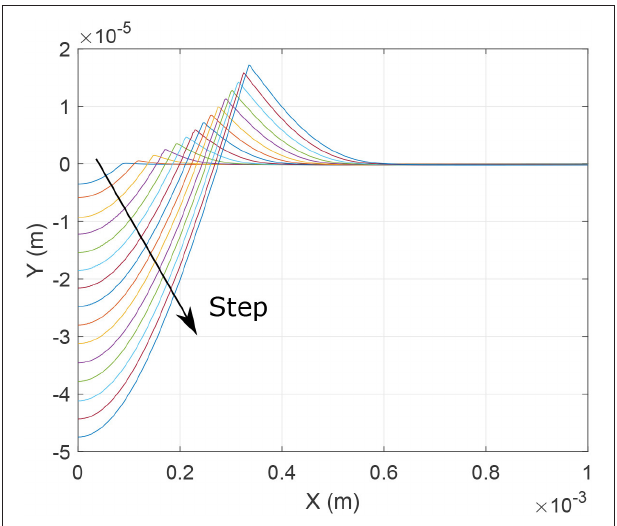
FIGURE 9 | Effect of loading (in 15 steps) on surface profile for elastic-perfectly plastic